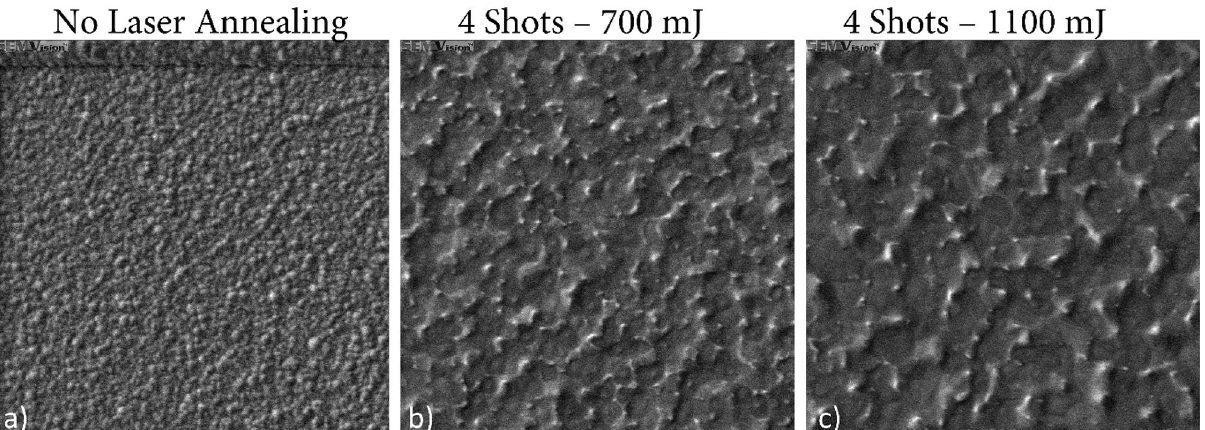
Figure 3. SEM images of the poly:Si substrate: ( a ) before laser annealing (a:Si), ( b ) after 4 laser shots with an energy of 700 mJ and ( c ) after 4 laser shots with an energy of 1100 mJ, highlighting the modification of the poly:Si surface due to the laser-annealing related grain